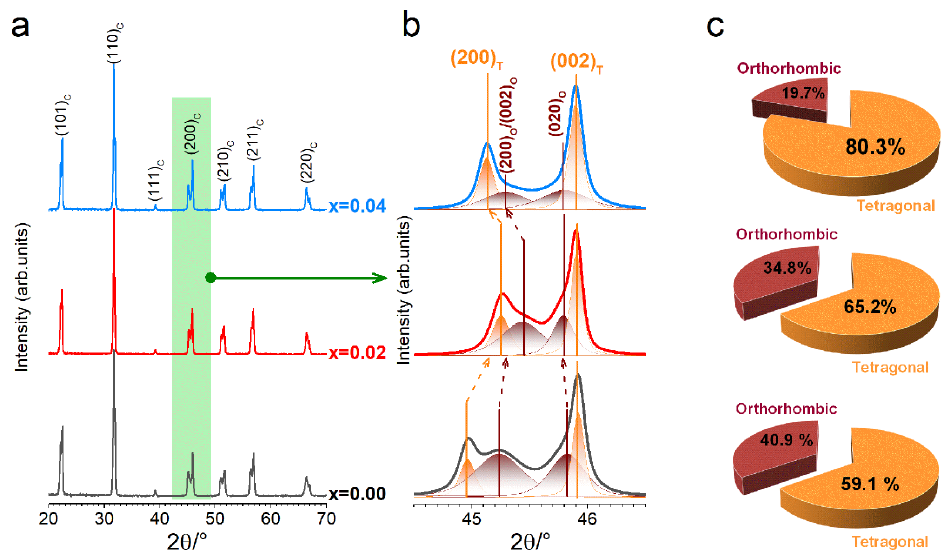
Figure 1. XRD patterns between the 2  range 20 to 70° ( a ) corresponding to the KNL − (N 0.9 − x TS x )sin- tered at 1125 °C for 2h, ( b ) zoomed in on the 2  range of 44.5 – 46.5°, ( c ) orthorhombic and tetragonal fraction at different Sb amounts. thorhombic and tetragonal fraction at different Sb